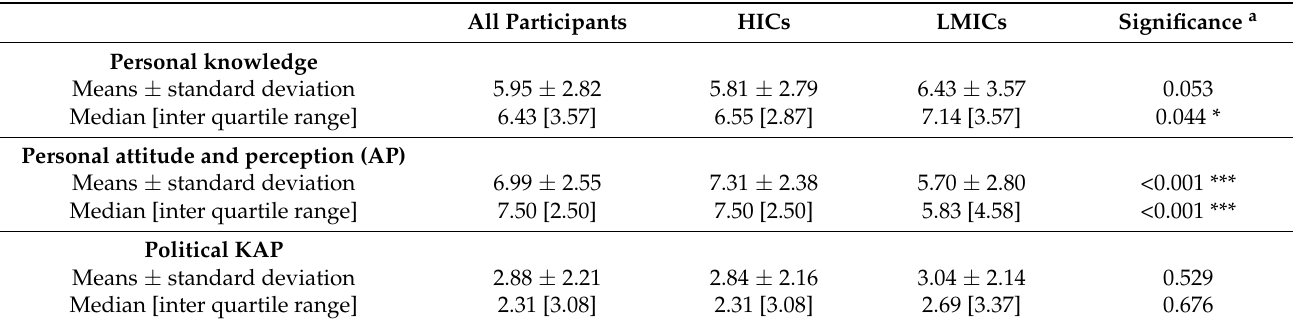
Table 2. Cumulative median and mean scores per assessment on AMR knowledge, attitude, and/or perception for all participants, stratified for high-income country (HIC) and low- and middle-income (LMIC) country participants. All scores had a maximum score of